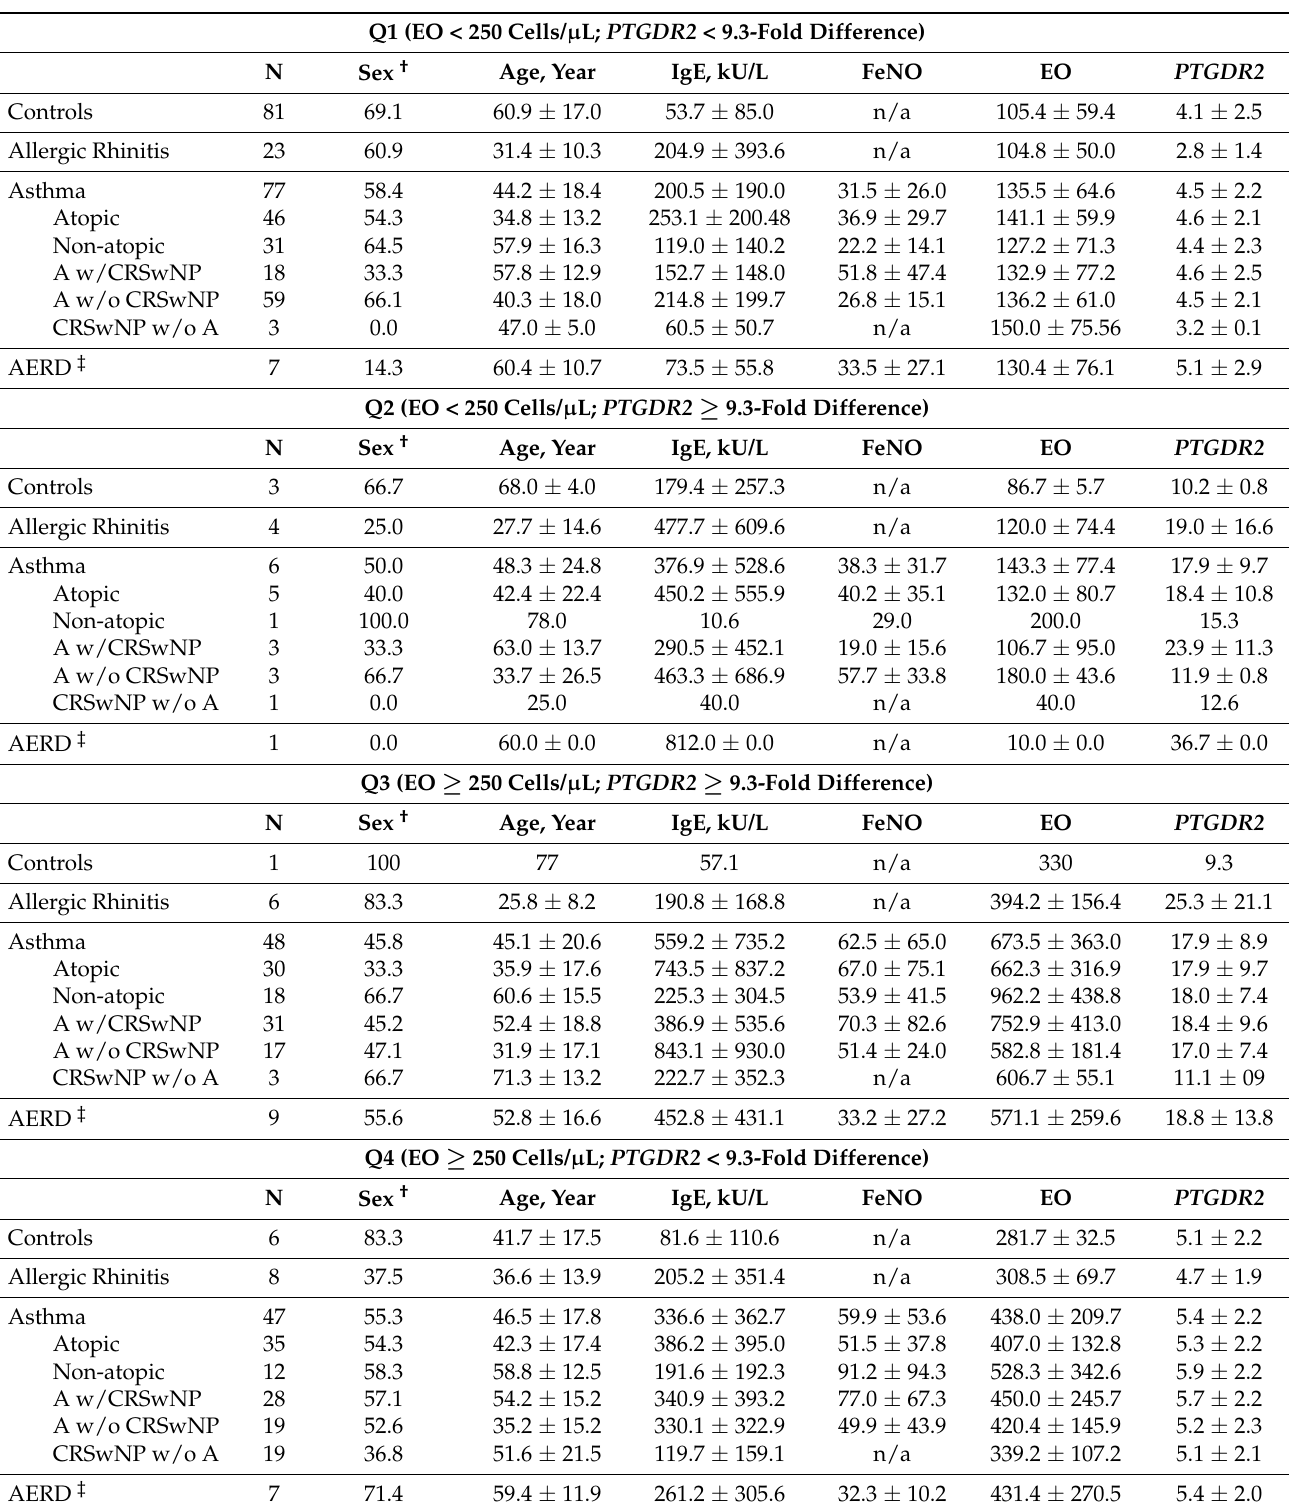
Table 8. Phenotypic and clinic characteristics of the four quadrants obtained by dividing according to values for eosinophils count (250 cells/ µ L) and PTGDR2 expression in controls (9.3-fold difference) both with a specificity ≥